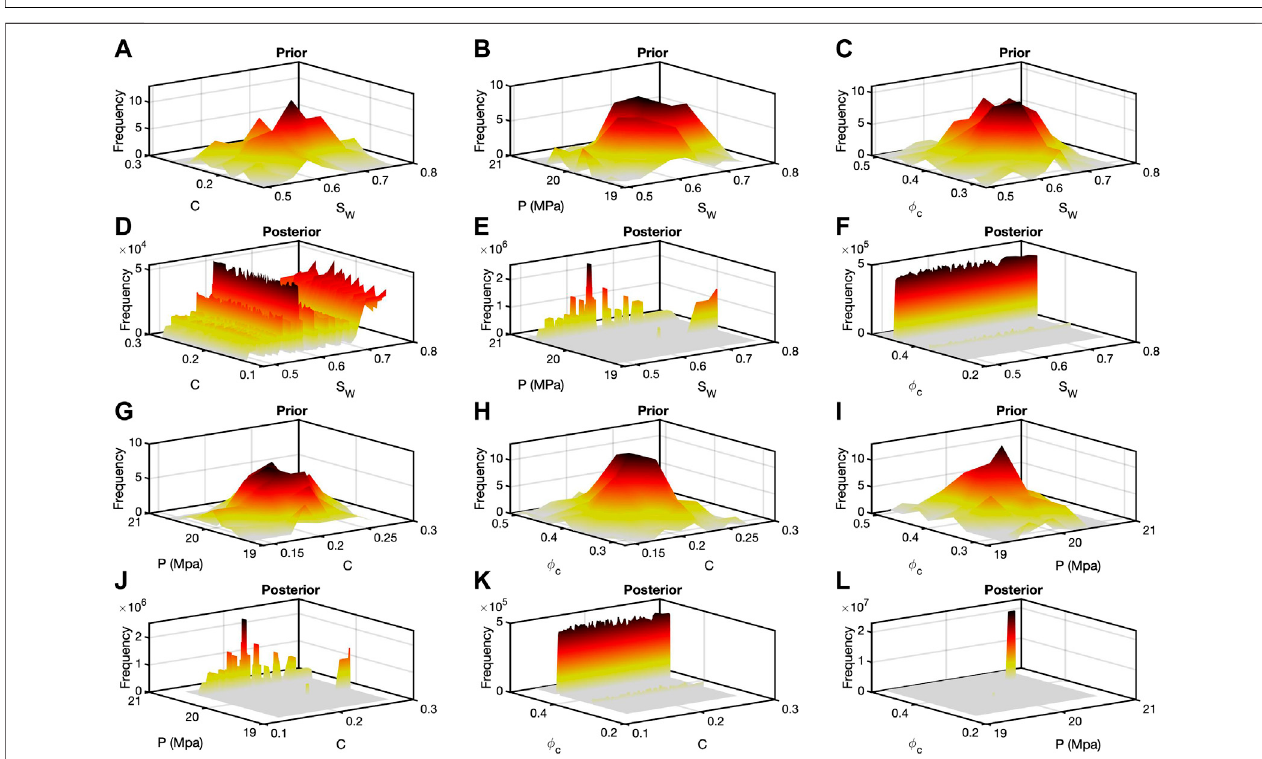
FIGURE 6 | Bivariate histograms for analysis two. The juxtaposition is the same as in Figure 5 . The prior model differed between analysis one and two, but the bivariate posterior histograms show patterns similar to those in Figure 5 .